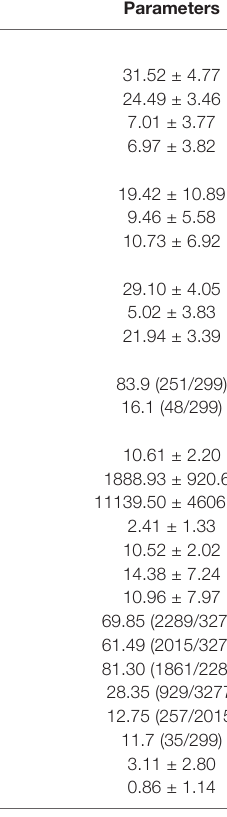
TABLE 1 | Basic characteristics and ICSI outcomes of the NOA patients with sperm retrieved by Micro-TESE.